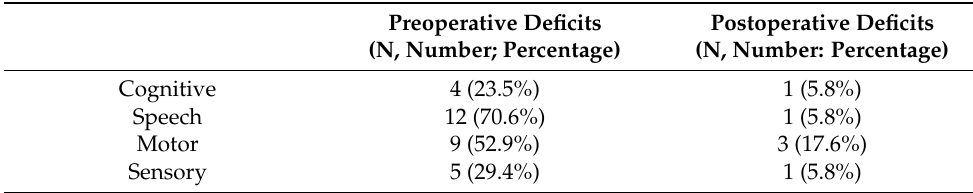
Table 3. Patient deficits before and following trans-sulcal tumor